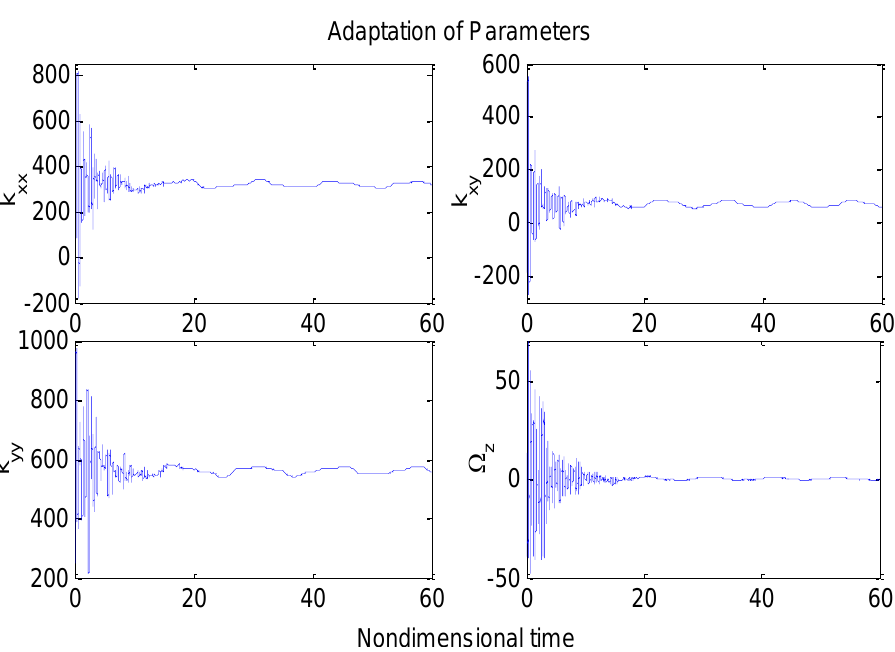
Figure 10. Adaptation of parameter estimates using the adaptive controller in [2].